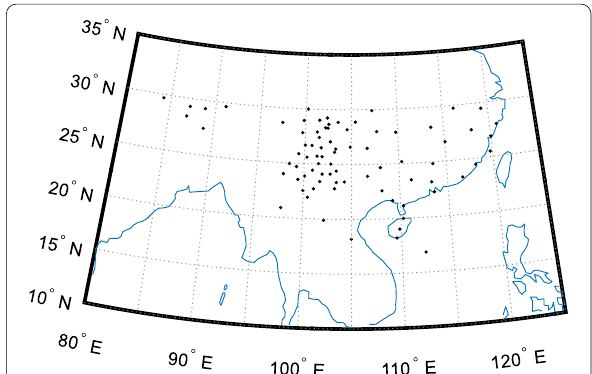
Fig. 1 Distribution of the GNSS receivers from